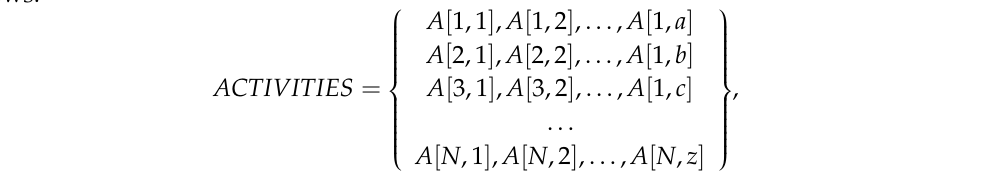
Algorithm 2: Algorithm for Determining the Features of the Frames